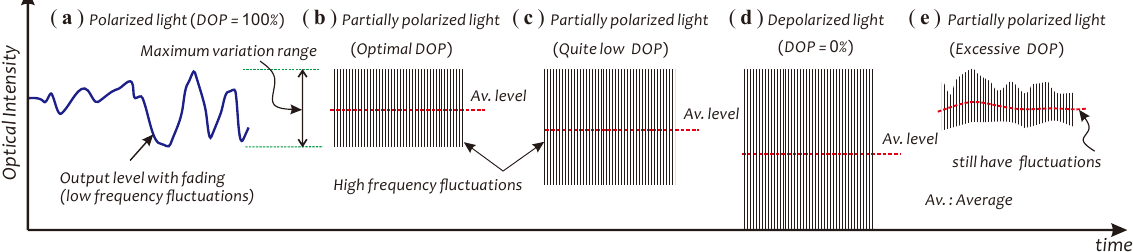
Figure 2. Schematics used for describing the concept of using degree of polarization (DOP) controllable, partially polarized light to relieve the polarization fading